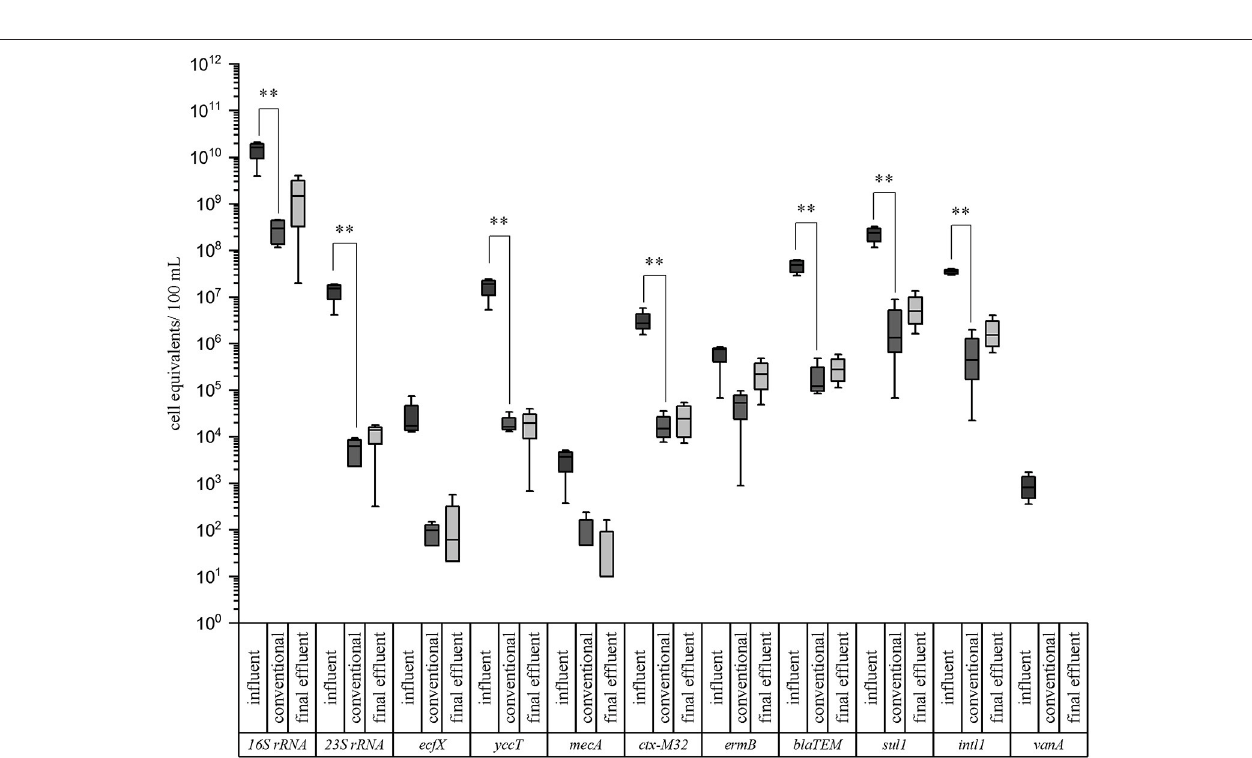
FIGURE 1 | Schematic illustration of the WWTP processes performed at the WWTP under investigation. (A) Conventional treatment with biological treatment (activated sludge and sedimentation tank) and (B) installation of semi-industrial advanced technologies.